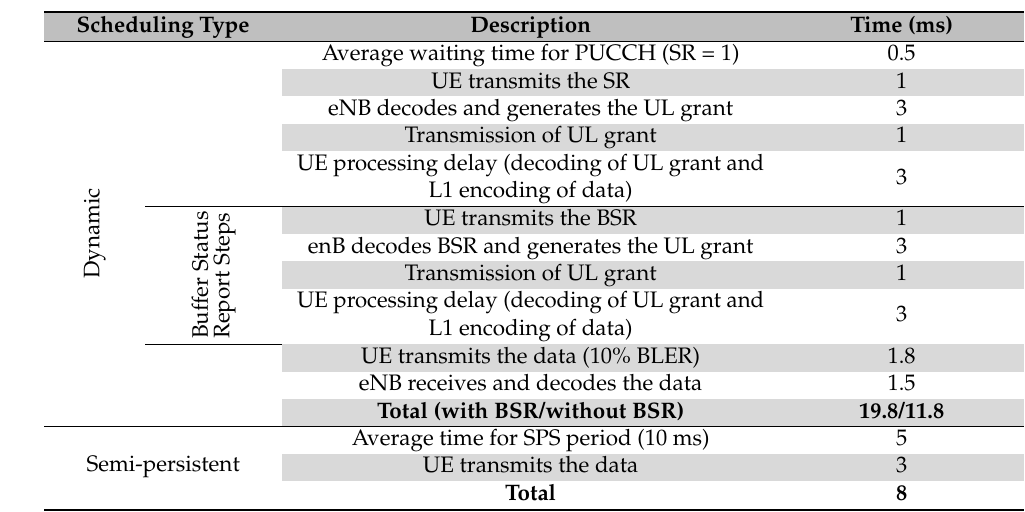
Table 5. Uplink delay in LTE-A [27].